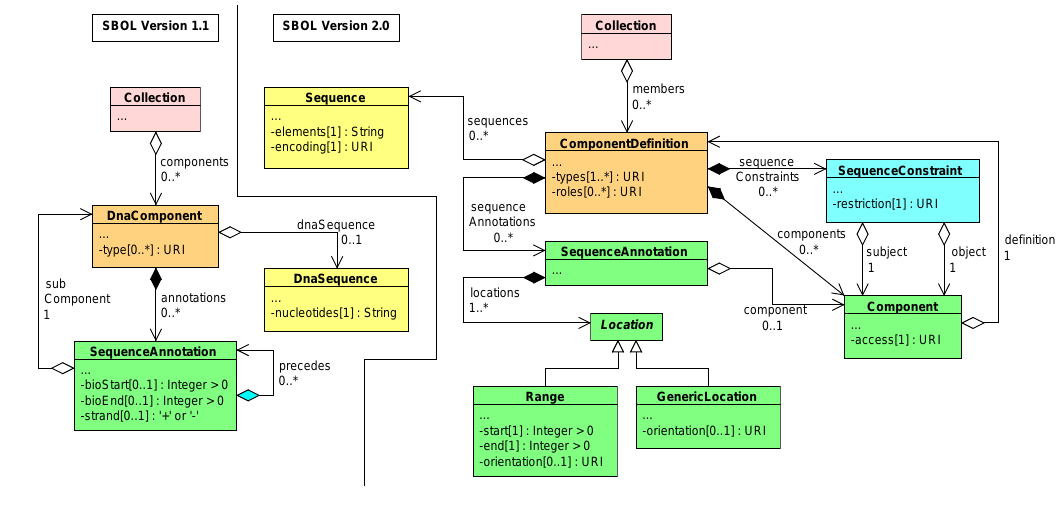
Figure 26: The mapping from the SBOL 1.1 data model to the SBOL 2.x data model, indicating corresponding class- es/properties by